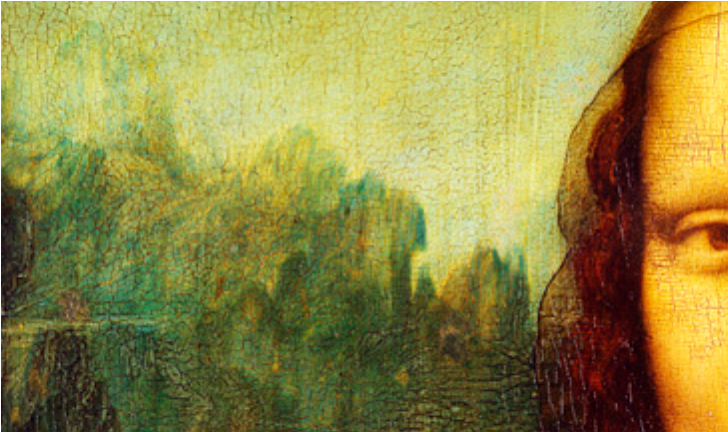
Figure 7. Unrealistic background landscapes in Renaissance paintings (example of Mona Lisa from Leonardo da Vinci).